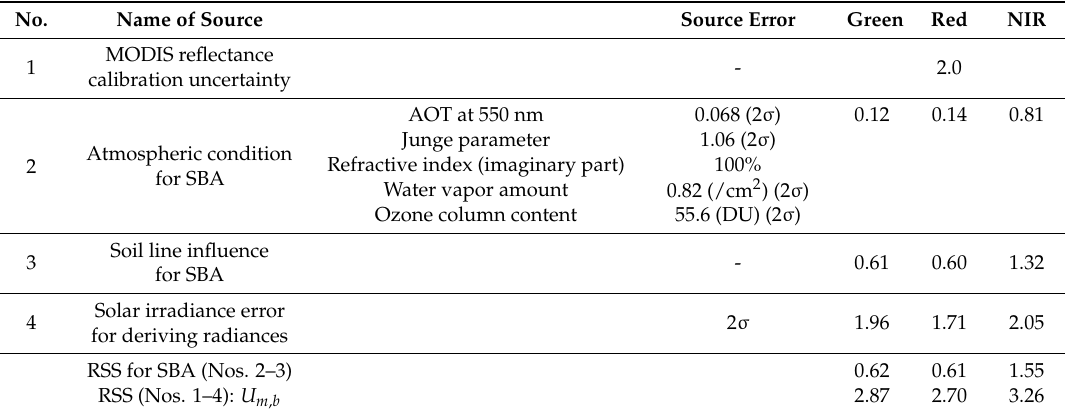
Table 4. Error budget table for spectrally adjusted MODIS (reference) radiances for ASTER-MODIS cross-calibration of VNIR bands showing individual uncertainty factors and combined uncertainty. The three right-most columns list the uncertainty in spectrally adjusted MODIS radiances. In the table, spectral band adjustment is abbreviated as